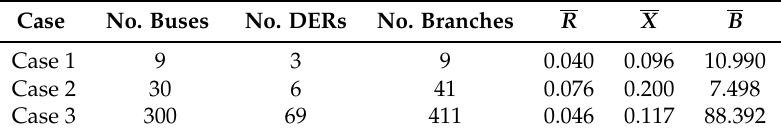
Table 1. Grid parameters for the three test systems. No. Buses , No. DERs and No. Branches represent the total number of buses, the number of buses with DER resources, and total number of branches respectively. R , X , and B are average series resistance, inductance, and shunt susceptance of all branches, respectively. The values are in per unit (p.u.) with 100 MVA